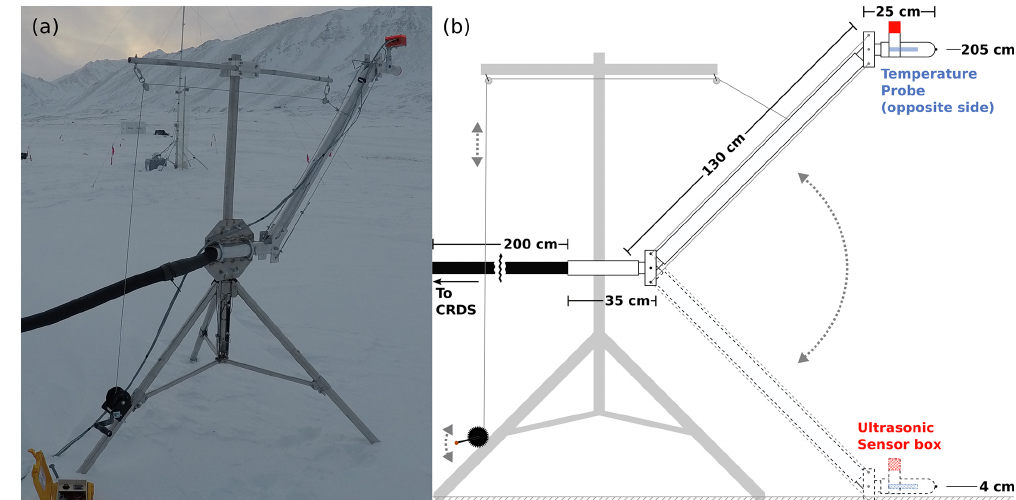
Figure 2. The profiling module, with articulating arm. (a) Profiling module during field deployment. The inlet “head” can be seen in upper right of photo, with ultrasonic distance sensors encased in red plastic housing. The temperature sensor (not visible) is located on opposite side of the “head”. The black winch in bottom left of the photo controls the inlet height via a pulley system. Also visible in the bottom left is the yellow case containing the power supply and data logger for temperature and distance sensors. Black tubing leading off to the left connects to ISE-CUBE inlet. (b) Dimensional diagram for articulating arm.